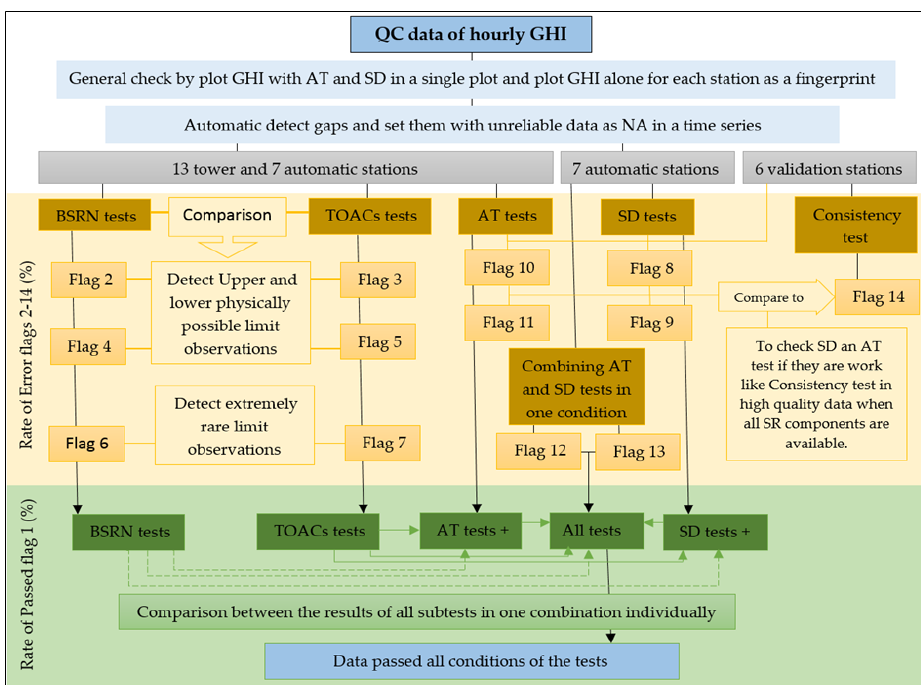
Figure 2. Flowchart of proposed quality control.